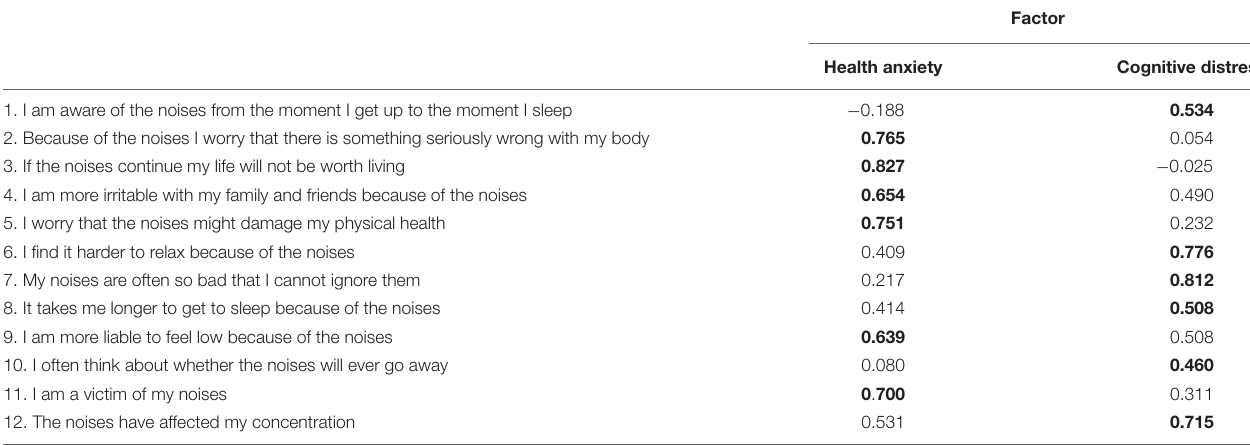
TABLE 3 | Results of the factor analysis (Pattern Matrix).